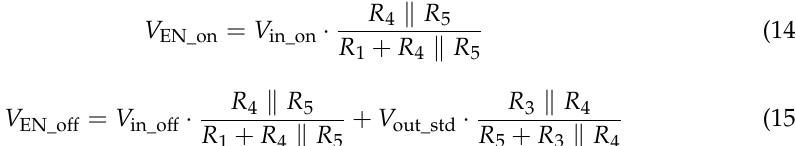
Thus, through the peripheral circuit design, the LDO can be turned on when the input voltage is higher than V in_on , and be turned off when the input voltage is lower than V in_off , as shown in Figure 9. V in_on and V in_off are easy to be calculated as: Based on the above analysis, the workflow of the system is presented, as shown in Figure 10. In the beginning, the voltage of C 1 ( V in ) is 0, the voltage-controlled LDO is turned off and the MCU is powered off, hence, the Q 3 and Q 4 are turned off. The system operates in energy harvesting mode. The equivalent circuit is shown in Figure 11. The CT with capacitance compensation sources energy from the transmission line. The full-bridge rectifier composed of diodes D 1 , D 2 , and body diodes of Q 3 and Q 4 converts the AC power on the secondary side of CT to DC power, and stores the energy in C 1 . When the voltage of C 1 reaches V in_on , the voltage-controlled LDO is turned on and the MCU is powered. The MCU starts to operate and turns Q 3 and Q 4 on. At this point, the system is switched to the current measurement mode. The equivalent circuit is shown in Figure 12. Since R 1 and R 2 are much smaller than ( j ω L m + R m ), the current through R 1 and R 2 follows Equation (1). The voltage values of R 1 and R 2 are sensed and entered into the ADC sampling pin of MCU after differential amplification. The current value of R 1 and R 2 is calculated by MCU, and the transmission line current is further calculated according to Equation (1). Finally, the results are sent via the wireless communication module to realize the further function. With energy consumption, the V in drops until it reaches V in_off , then the voltage-controlled LDO is turned off. The MCU is out of power and the Q 3 and Q 4 are turned off. Then the system re-enters the energy harvesting mode, and the cycle repeats. In a time-multiplexed cycle, the energy consumed by the sensor